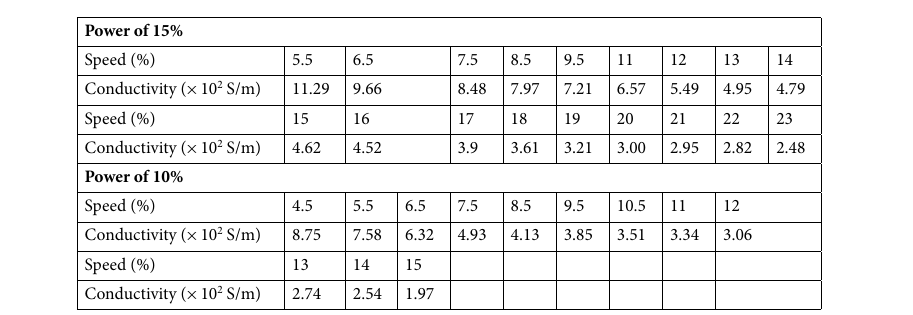
Figure 1. Scaning electron microscopy images of ( a ) porous morphology of the laser ablated pattern ( b ) improper carbonization obtained for few combinations showing the absence of porous morphology ( c ) LIG pattern after subjected to heating for 3 h.